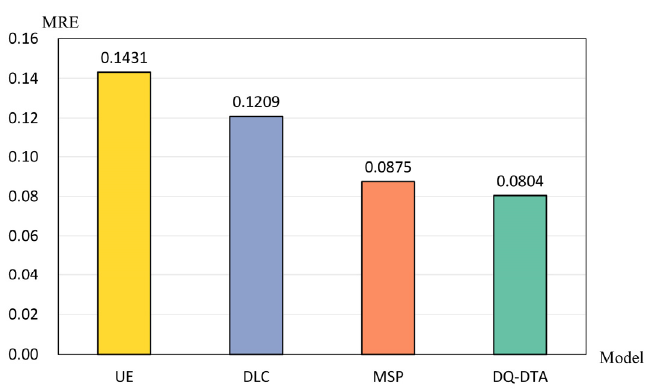
ISPRS Int. J. Geo-Inf. 2020 , 9 , x FOR PEER REVIEW